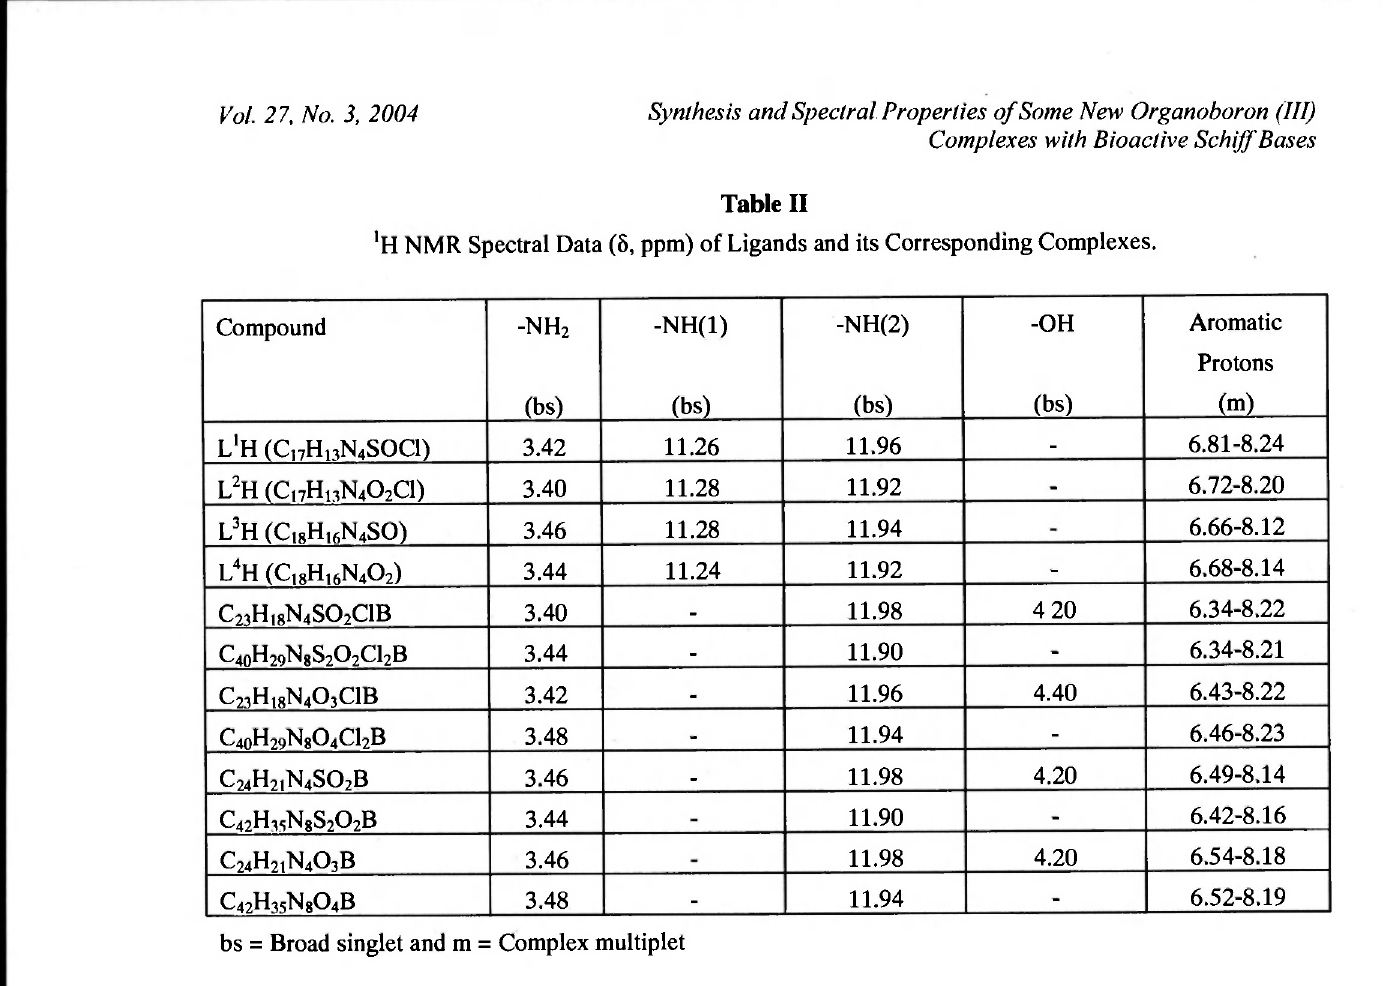
'H NMR Spectral Data (δ, ppm) of Ligands and its Corresponding